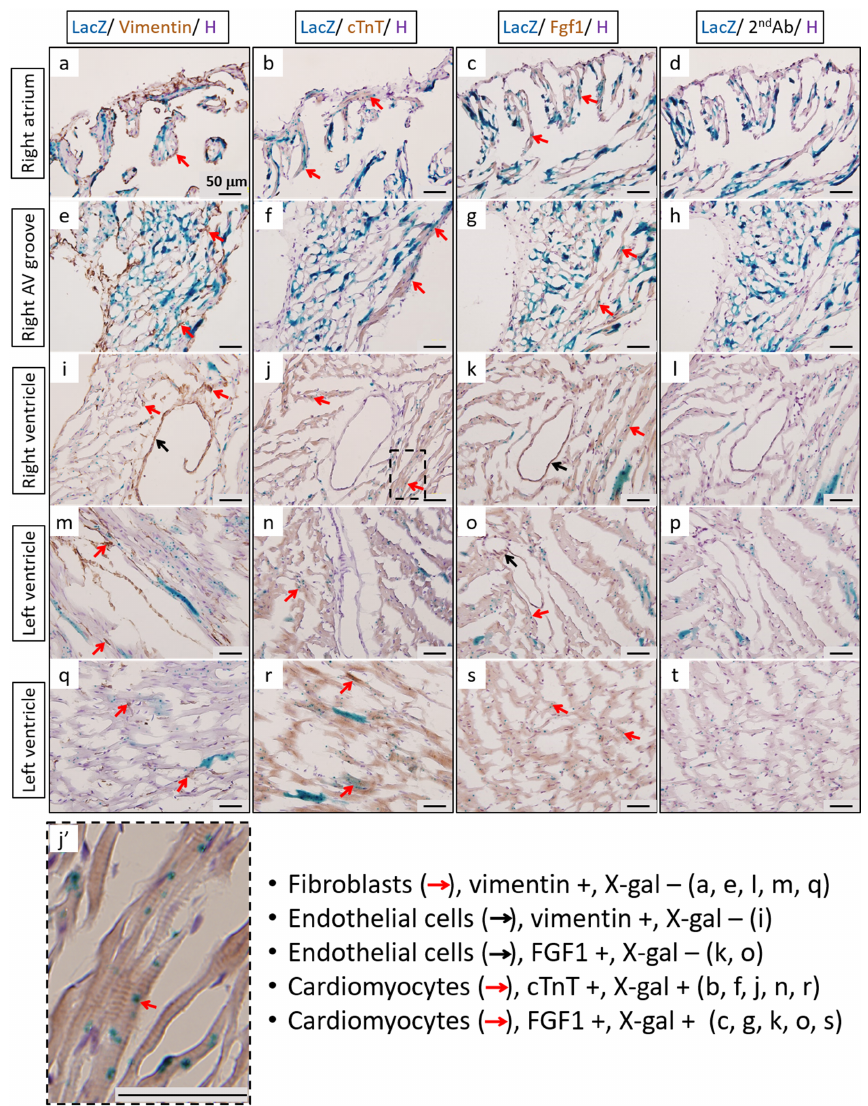
Figure 5. Expression profile of F1A -driven expression of LacZ gene in F1A-CreER T2 x ROSA26 F1 mice. ( A ) LacZ-positive signals showed tissue-specific and dose-dependent manner after tamoxifen treatment. LacZ-positive blue signals of LacZ staining were detected only in heart tissues of F1A- CreER T2 x ROSA26 F1 transgenic mice after tamoxifen treatment (Panels e , f ) but not in brain (Panels b , c ) and kidney (Panels h , i ). No LacZ staining could be detected in the absence of tamoxifen administration (Panels a , d , g ). Scale bar, 2 mm ( a – c ); 50 µ m ( d – i ). ( B ) The LacZ-positive cells in the heart were counted and the data were expressed as mean ± SEM, n = 3. ( C1 ) Whole mount LacZ staining of heart and kidney organs. ( C2 ) Spatial distribution of LacZ-positive cells in the heart. LA: left atrium, LV: left ventricle, IVS: inter-ventricular septum, RA: right atrium, RV: right ventricle. AV groove: atrium and ventricle groove Scale bar, 50 µ m. ( D ) LacZ-positive cells were not co-localized with vimentin-positive fibroblasts and endothelial cells (( a , e , i , m , q ), red arrows). LacZ-positive cells were exclusively co-localized with cTNT-positive cells (( b , f , j , n , r ), red arrows). LacZ-positive cardiomyocytes were co-localized with FGF1-positive cells (( c , g , k , o , s ), red arrows). Of note, some FGF1-positive cells were not only co-localized with cardiomyocyte, but co-localized with endothelial cells (( k,o ), black arrows), indicating different Fgf1 promoters were used for different cell types in the heart. ( j’ ) A high magnification picture of a portion of Panel ( j ) is to demonstrate cardiac-specificity of the Cre expression. Scale bar, 50 µ m. H: